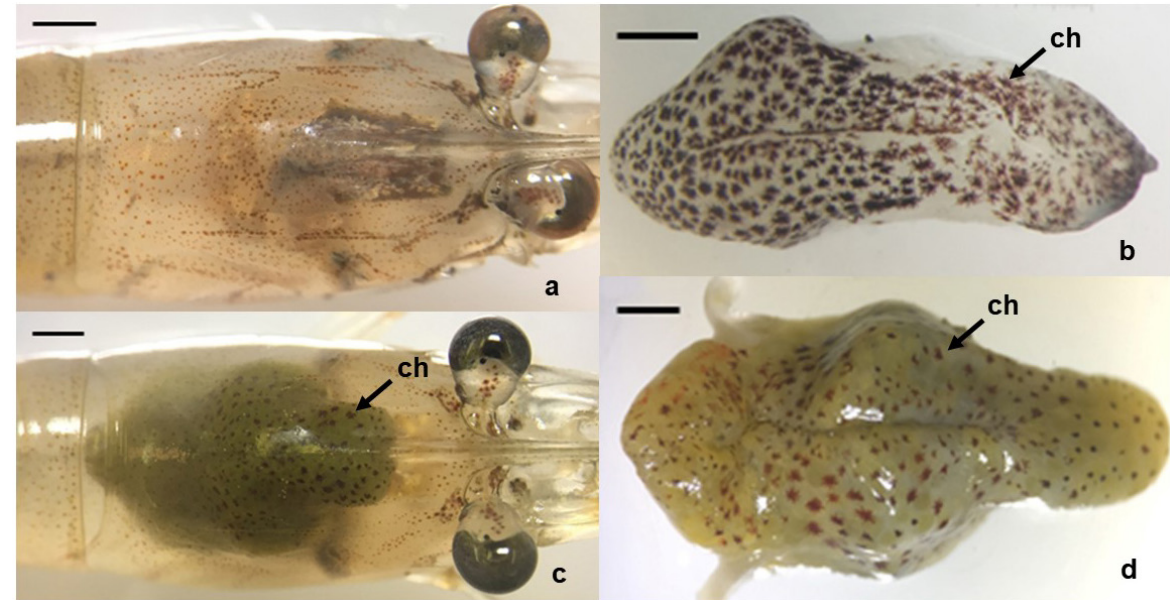
Figure 1. Macrobrachium acanthurus. a) Dorsal view of the female cephalothorax with the ovaries in spent developmental stage (after spawning); b) Spent ovaries dissected; c) Dorsal view of female cephalothorax with ovaries in the mature stage; d) Mature ovaries dissected. Scale bar = 2 mm. Chromatophores -